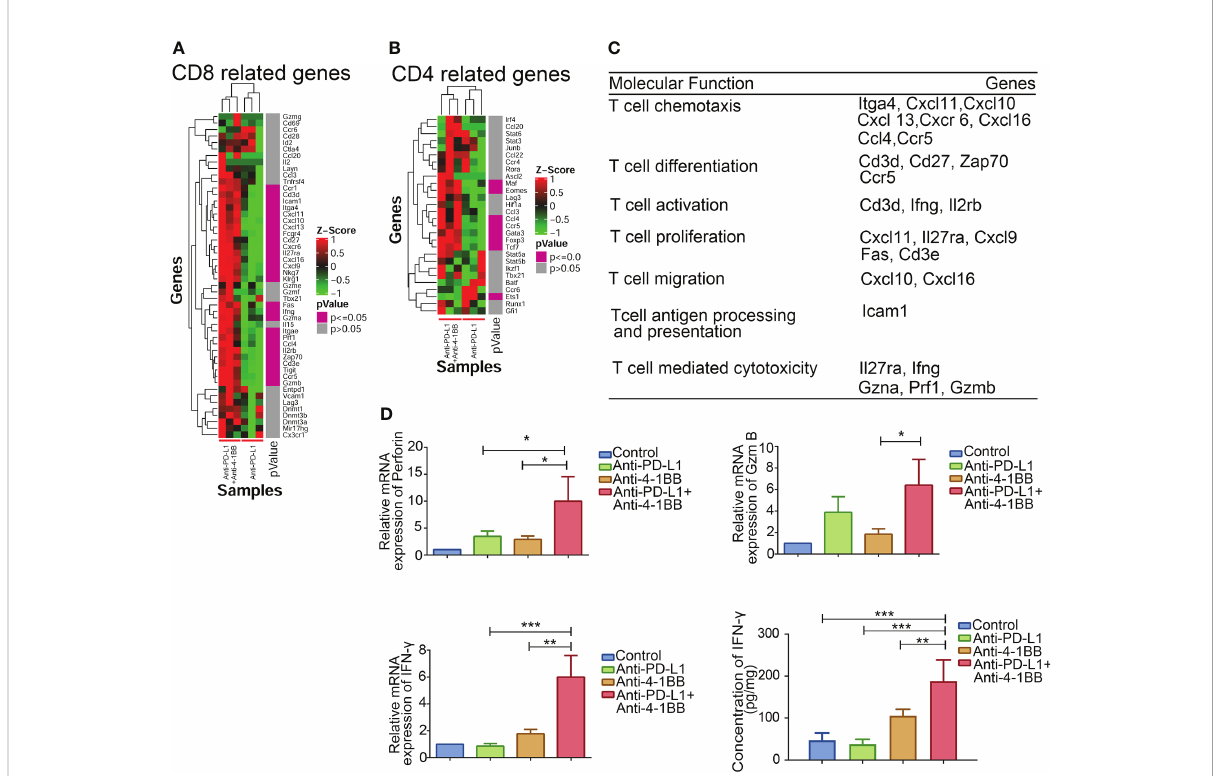
FIGURE 4 Functions of CD8 + T cells in the combination therapy. (A, B) Combinational therapy signi fi cantly upregulated genes related to CD8 + and CD4 + T cells. (C) Genes were classi fi ed and grouped based on their molecular function. (D) Perforin, IFN- g , and granzyme B in tumors were measured by RT-PCR or ELISA after combinational treatment (n = 3, mean ± SD). * means p-value < 0.05, ** means p-value < 0.01, and *** means p- value <